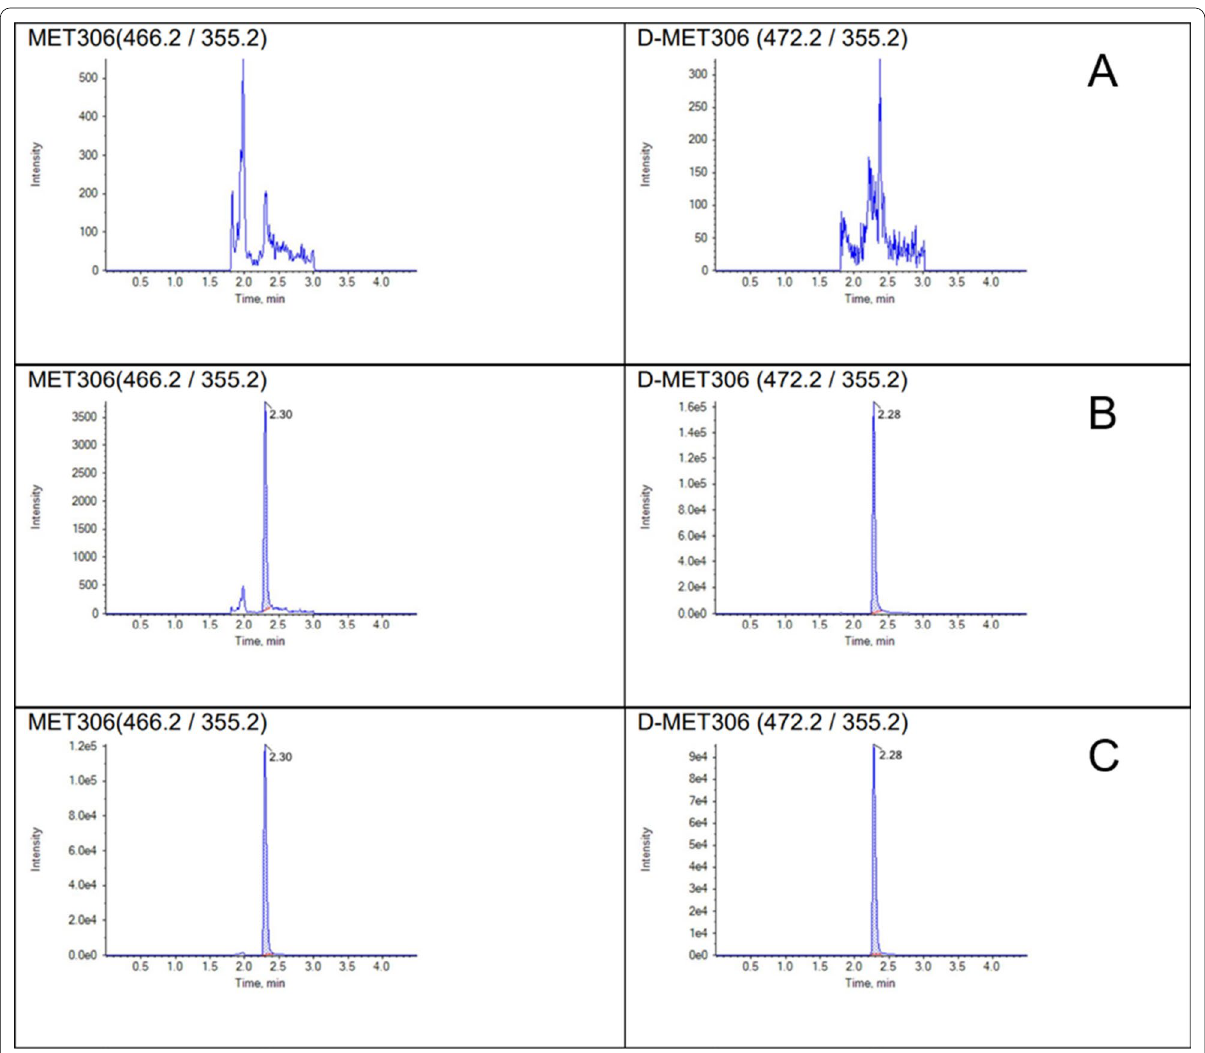
Fig. 2 Representative chromatograms of MET306 and IS in plasma. *The representative chromatograms of MET306 and IS in plasma: ( A ) a blank plasma sample; ( B ) LLOQ sample; ( C ) A plasma sample (3 h after dosing) of oral administration (30 mg) of MET306 in NSCLC